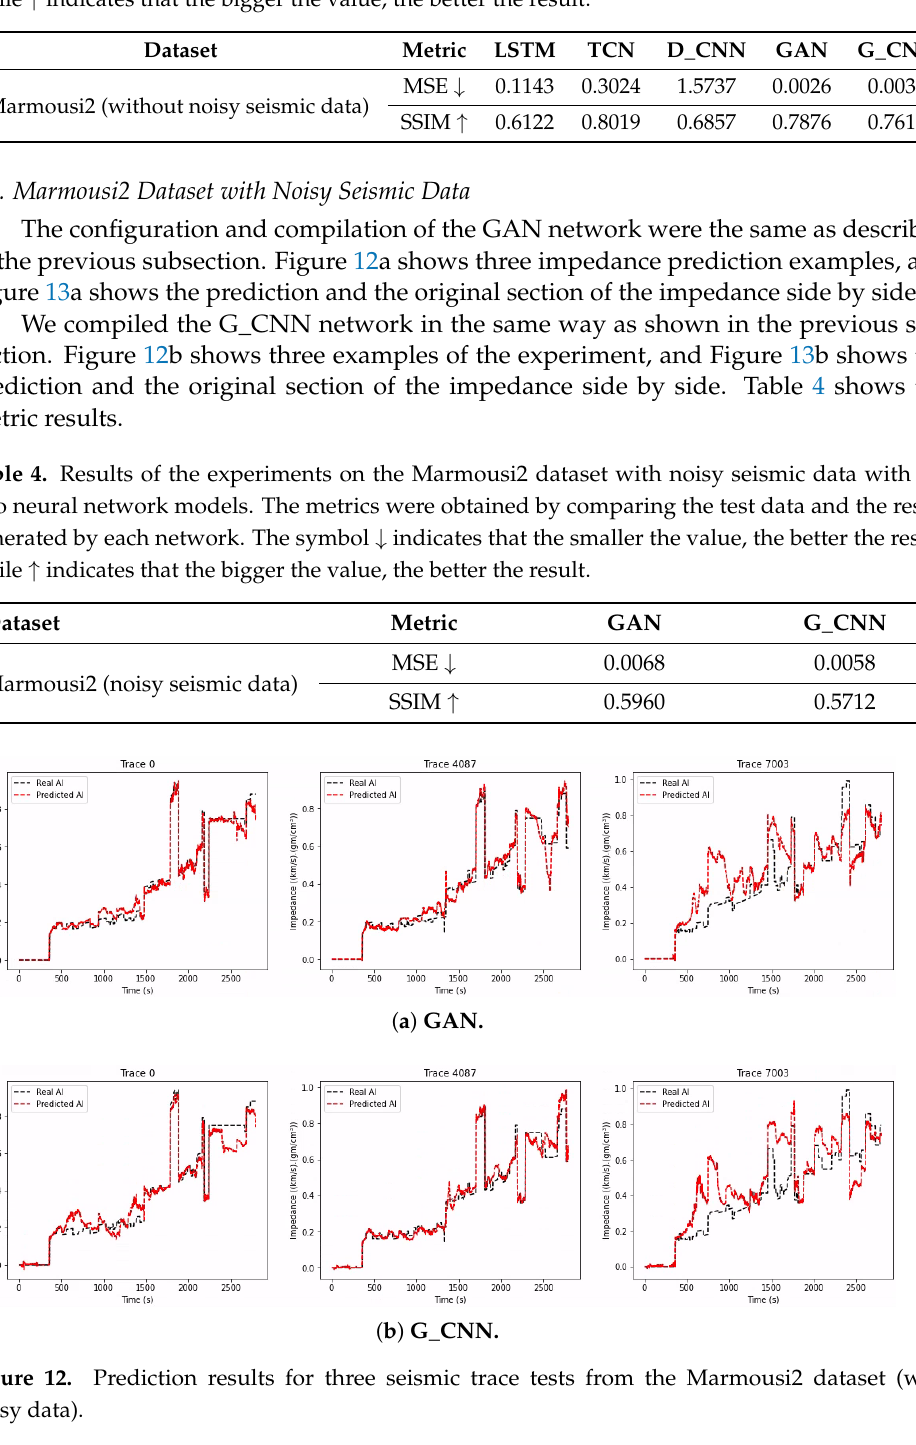
Table 3. Results of the experiments on the Marmousi2 dataset without noisy seismic data with the three neural network models. The metrics were obtained by comparing the test data and the result generated by each network. The symbol ↓ indicates that the smaller the value, the better the result, while ↑ indicates that the bigger the value, the better the result.